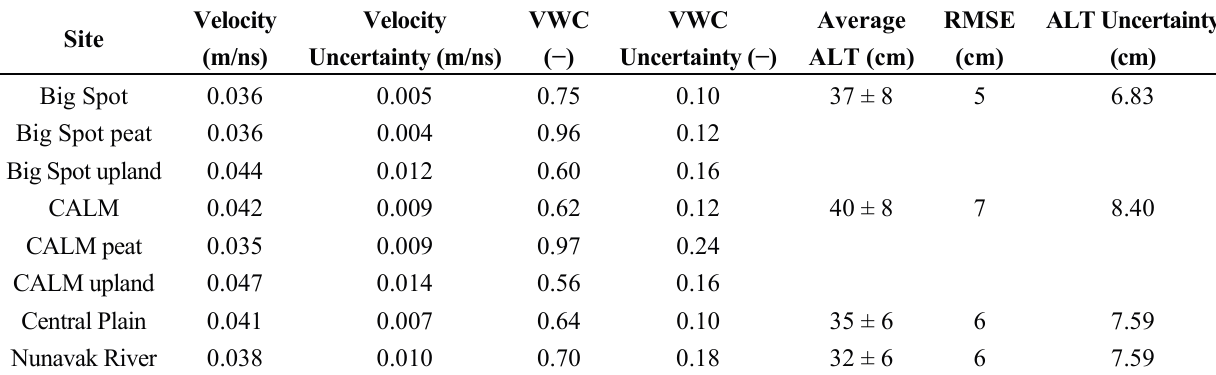
Figure 2. A schematic diagram showing the three classes of χ 2 used to evaluate ReSALT. An ideal match occurs when ReSALT and observed active layer thickness (ALT) fall into each other’s uncertainty bars. A good match occurs when the observed ALT falls within the ReSALT uncertainty, but ReSALT does not fall within the observed ALT uncertainty. No match occurs when only the uncertainty bars overlap or do not overlap at all. Table 2. Summary of Ground Penetrating Radar (GPR)